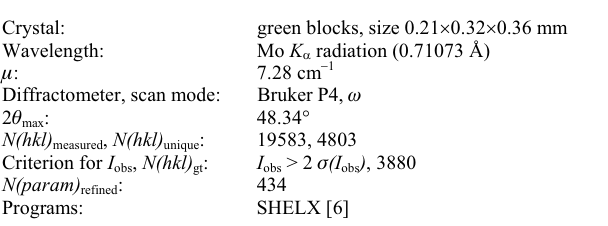
Table 1. Data collection and handling.